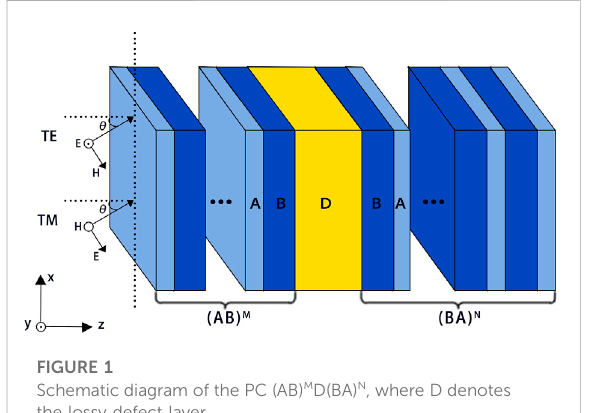
FIGURE 1 Schematic diagram of the PC (AB) M D(BA) N , where D denotes the lossy defect layer.